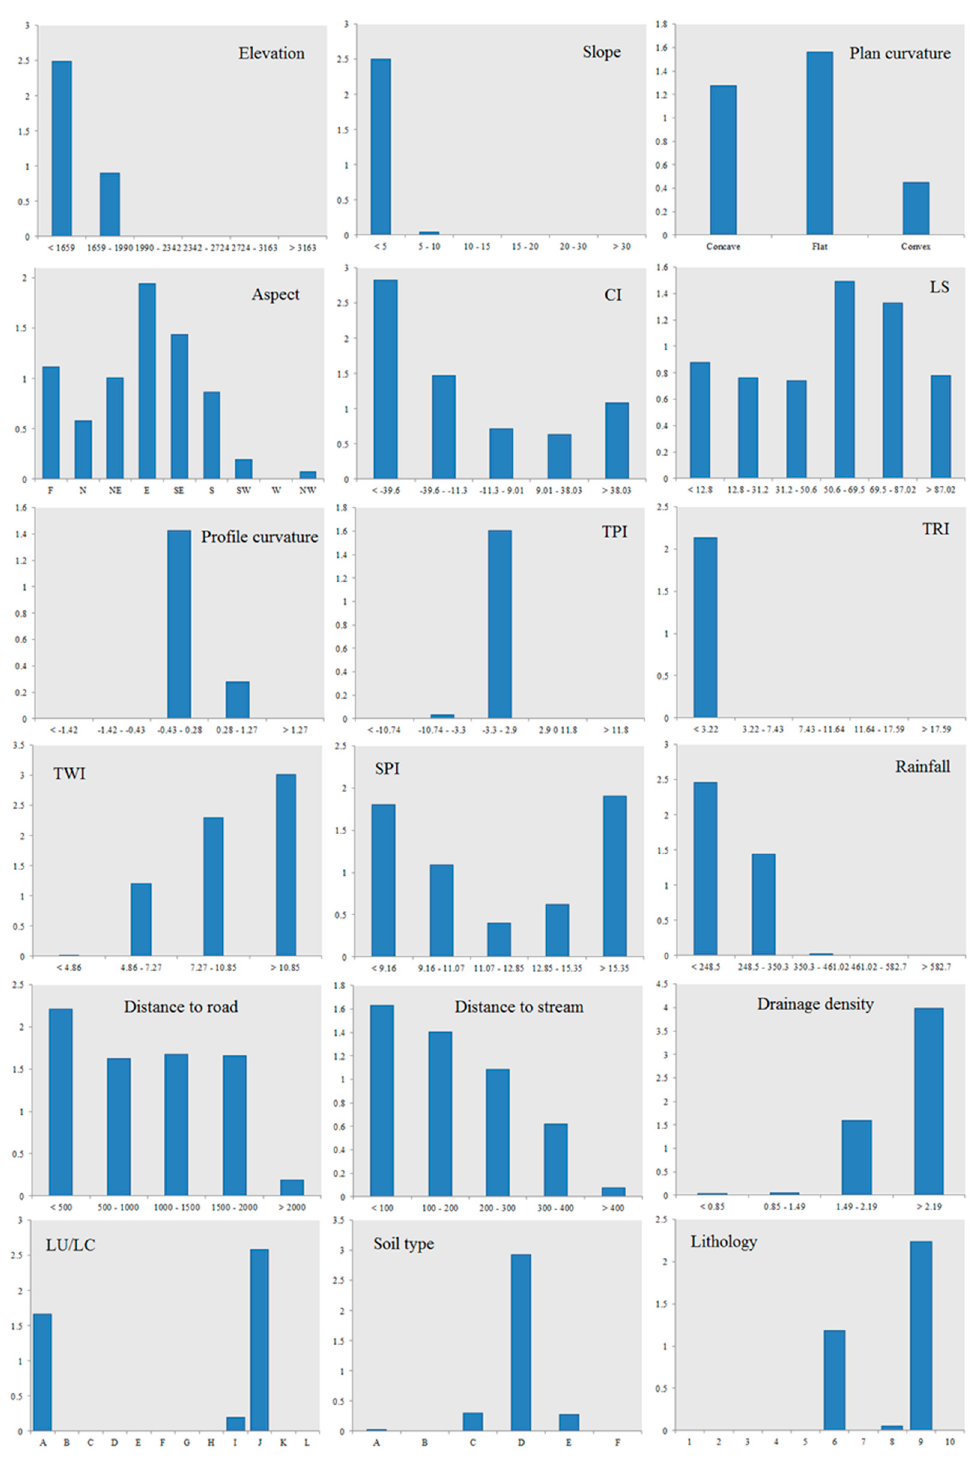
Figure 5. The spatial relationship between conditioning factors and gully locations. Table 3. The spatial relationship between gully erosion conditioning factors and gully locations.